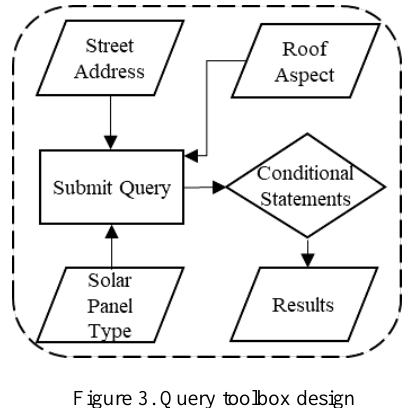
Figure 3. Query toolbox design